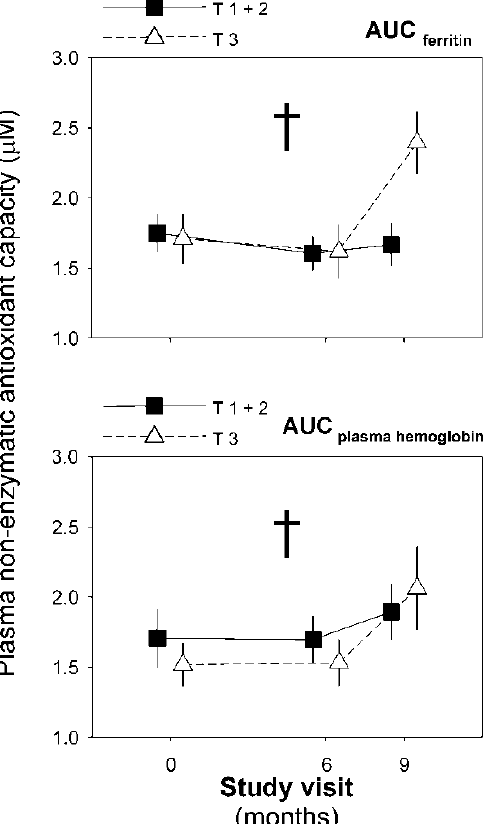
Figure 5. Changes in plasma non-enzymatic antioxidant activity throughout the experimental phase of the trial as a function of the changes in plasma ferritin and hemoglobin grouped by tertiles. We show data as means (SEM) of the patients remaining at each visit of the trial even though we conducted intention-to-treat statistical analyses. Data were submitted to a repeated-measures general linear model introducing the upper tertile (T3) vs. mid and lower tertiles (T1 + 2) as between-subjects factors. † Statistically signi fi cant interaction between the visits and tertile subgroups.